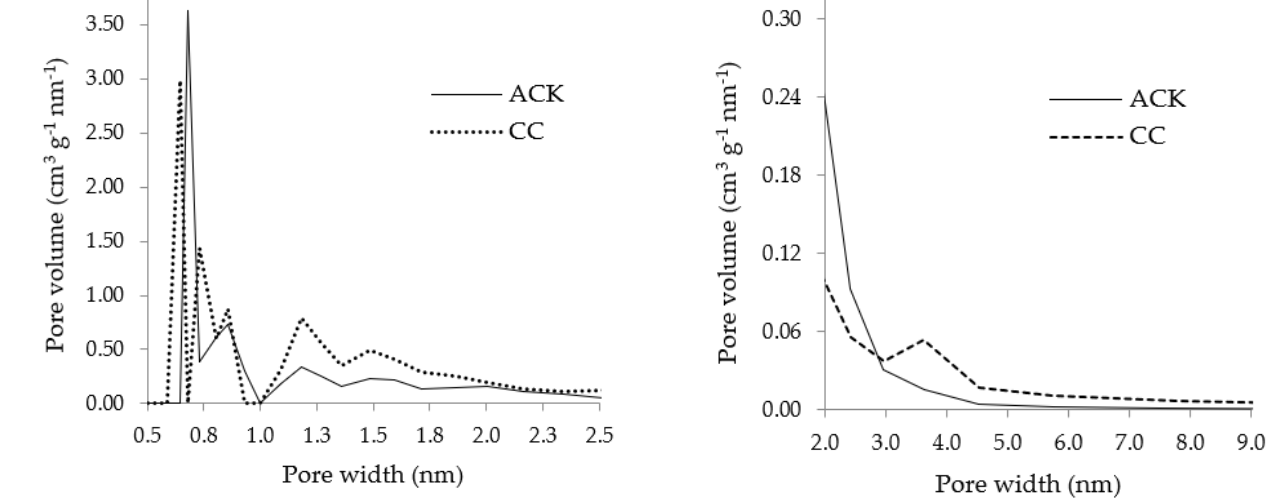
Figure 1. Micropore size distribution (DFT adsorption model for carbon slit-shaped pores) ( left ) and mesopore size distribution (BJH method) ( right ) of the carbon samples.